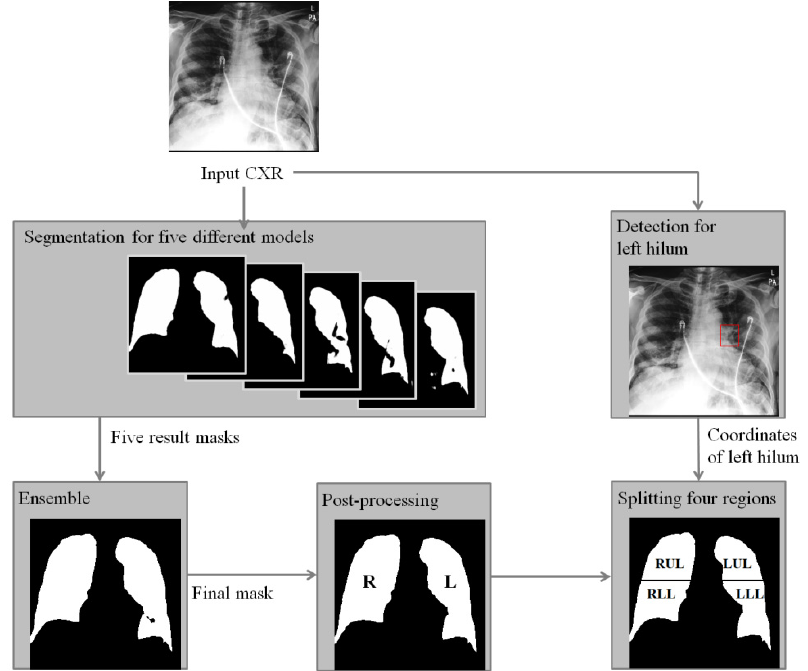
Figure 1. A flowchart of the proposed algorithm for segmentation of zones of the lung in CXR of COVID-19 patient. Right (R) and left (L) lung masks are generated by an ensemble method based on the majority voting from five lung masks predicted by models trained with different conditions. Then, left hilum and carina are detected and used to find a central point to split the whole lung into upper and lower regions. Finally, right upper lung (RUR), right lower lung (RLR), low upper lung (LUR), and left lower lung (LLR) are obtained.